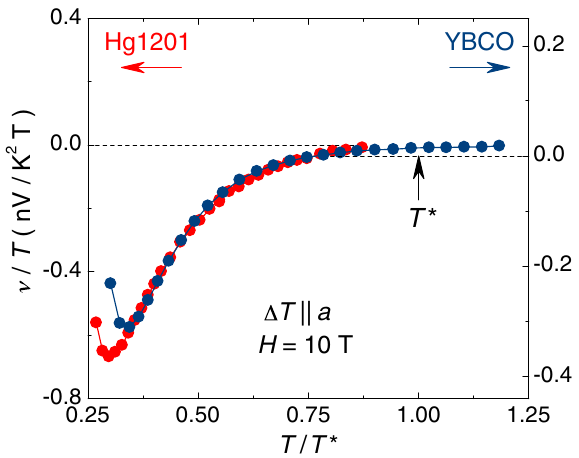
FIG. 4. Nernst coefficient (cid:2) of Hg1201 ( T c ¼ 65 K ; red circles, sample A ) and YBCO ( T c ¼ 66 K , p ¼ 0 : 12 ; blue circles, from Ref. [23]), plotted as (cid:2)=T versus T=T ? , where T ? is the pseudogap temperature as defined in the main text. Here, T ? ¼ 340 K for Hg1201 and T ? ¼ 250 K for YBCO. The magnetic field H ¼ 10 T is along the c axis, and the heat gradient is along the a axis. Note the different vertical scales for Hg1201 (red arrow, left axis) and YBCO (blue arrow, right axis). Below T=T ? ¼ 1 : 0 , the quasiparticle signal falls gradually to reach large negative values, in identical fashion in the two